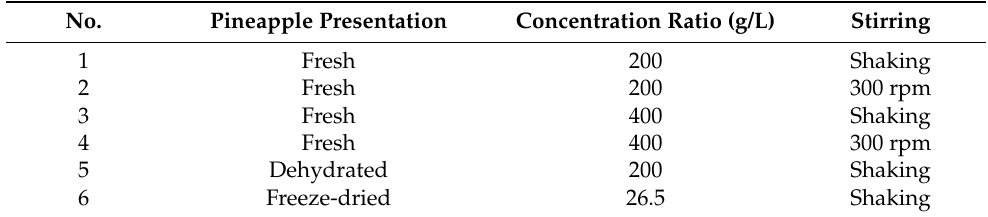
Table 1. Experiments carried out (in duplicate) using traditional maceration.